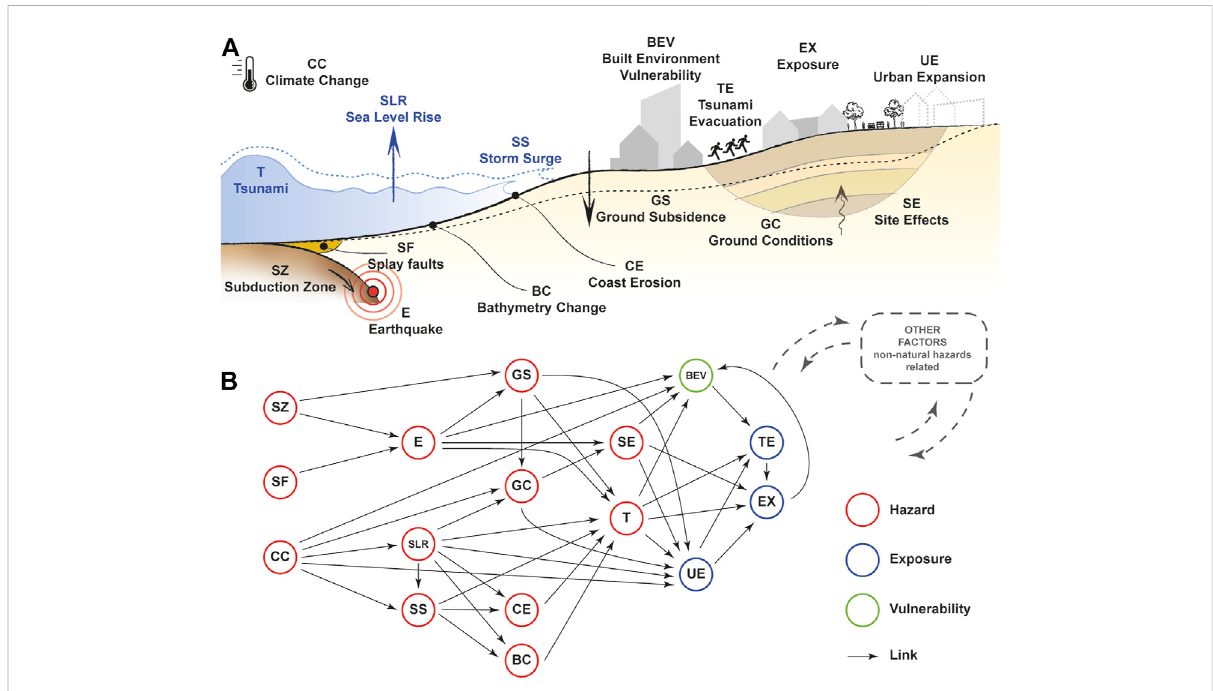
FIGURE 1 (A) Cascading compounding climate-geological hazards and effects. (B) Network-based schematisation of the dynamic risk for coastal communities in subduction